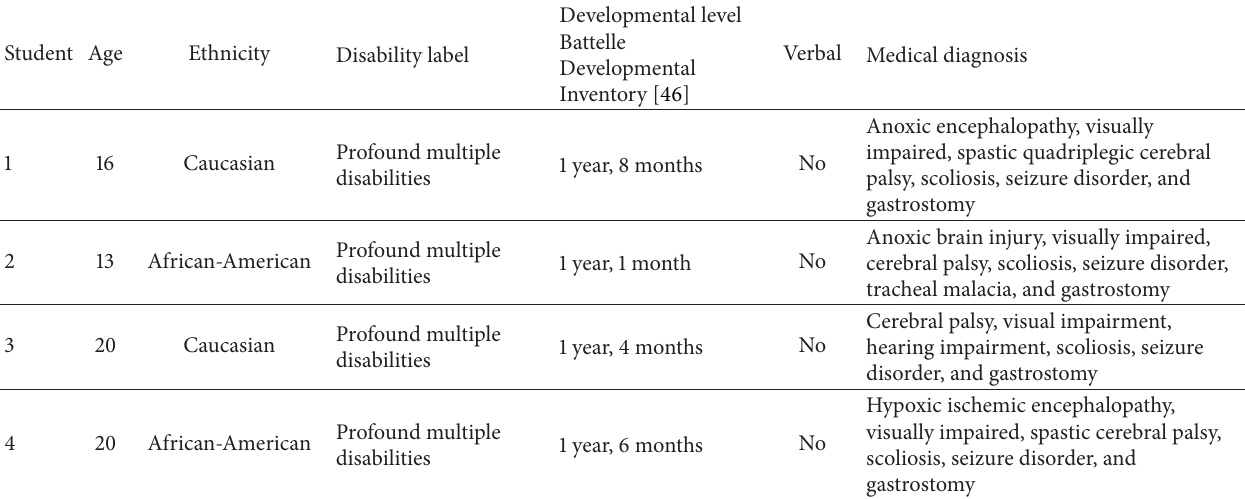
Table 1: Characteristics of